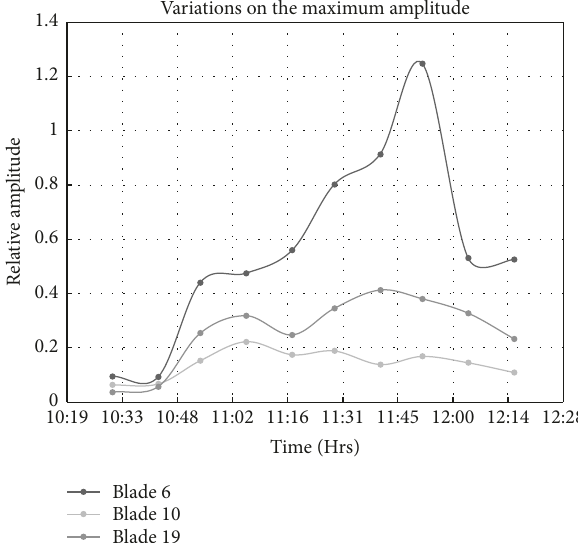
Figure 10: Variations of the maximum correlation as a function of the blade location for different events. Figure 11: Variations of the maximum amplitude as a function of time (all events), blade number